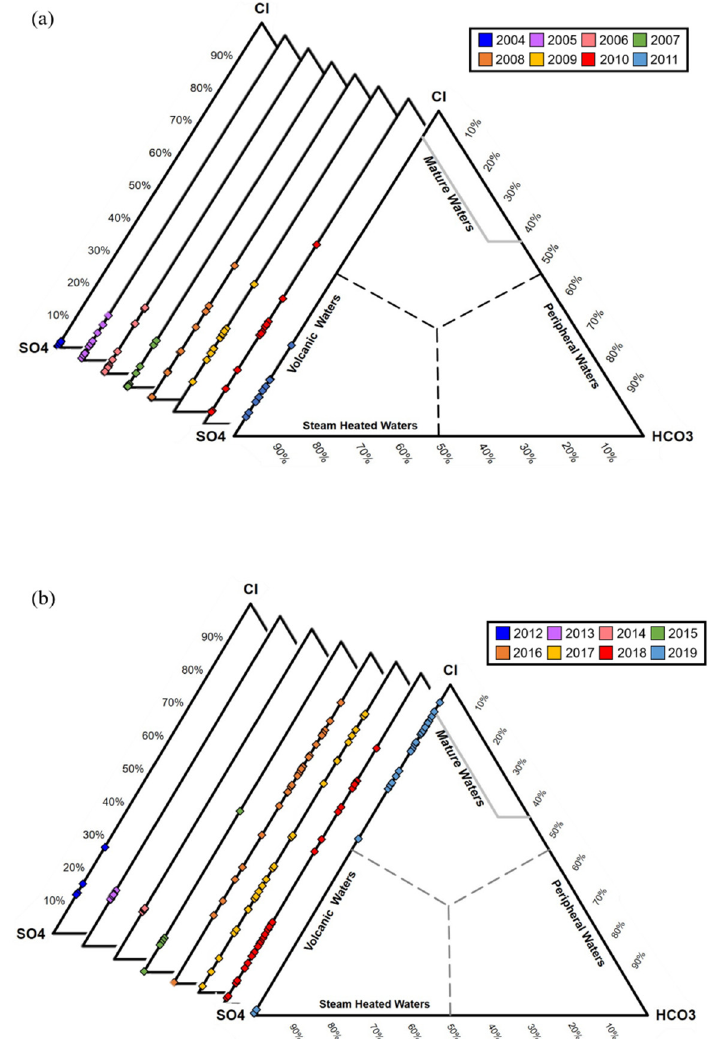
Figure 3. Cl-SO 4 -HCO 3 ternary diagrams for TYK thermal water: ( a ) 2004–2011; ( b ) 2012–2019.